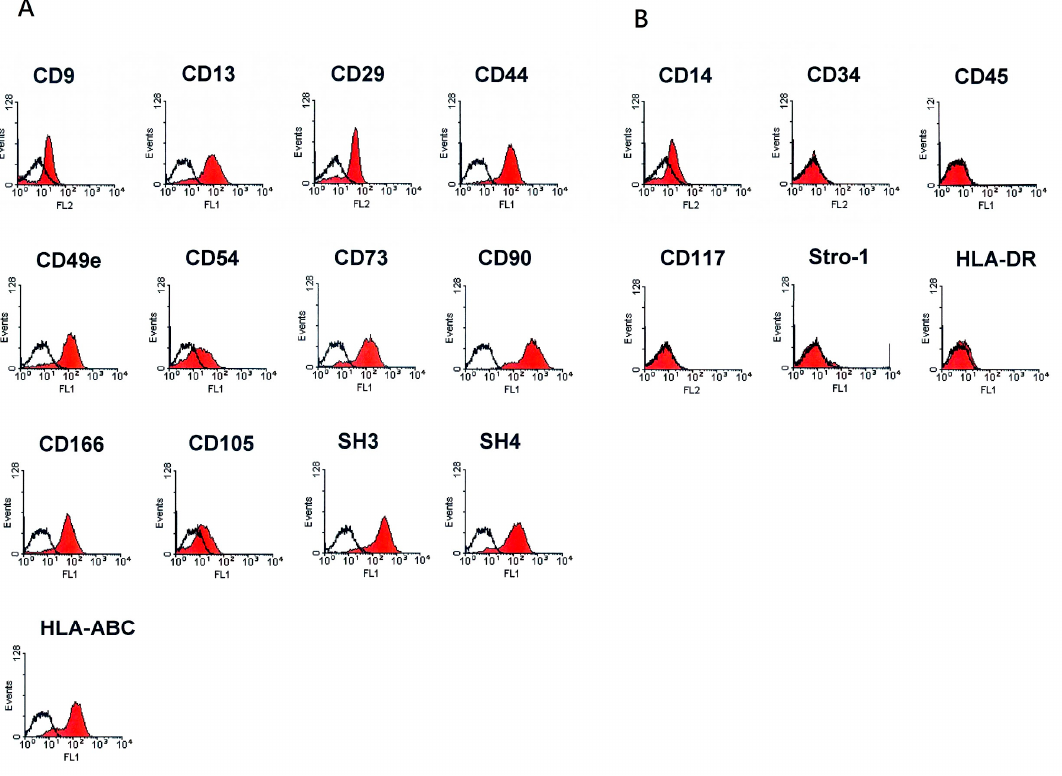
Figure 1. Phenotypic expression of placenta-derived multipotent stem cells (PDMCs). The results of flow cytometry revealed HLA-ABC + , CD29 + , CD44 + , CD9 + , CD90 + , CD105 + , SH3 + , SH4 + , CD166 + , CD13 + , CD49e + , and CD54 + and HAL-DR - , CD45 - , CD34 - , Stro-1 - , and CD117 - . ( A , B ) markers for MSCs (mesenchymal stem cell) and hematopoietic cells, respectively.